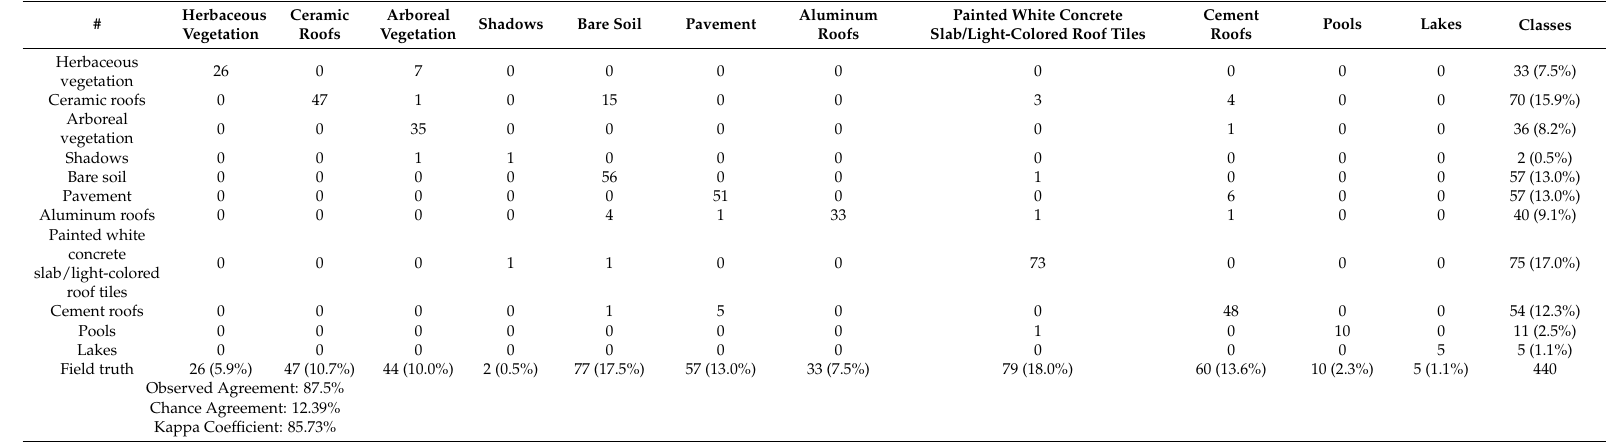
Table 2. Satellite image classification confusion matrix and kappa